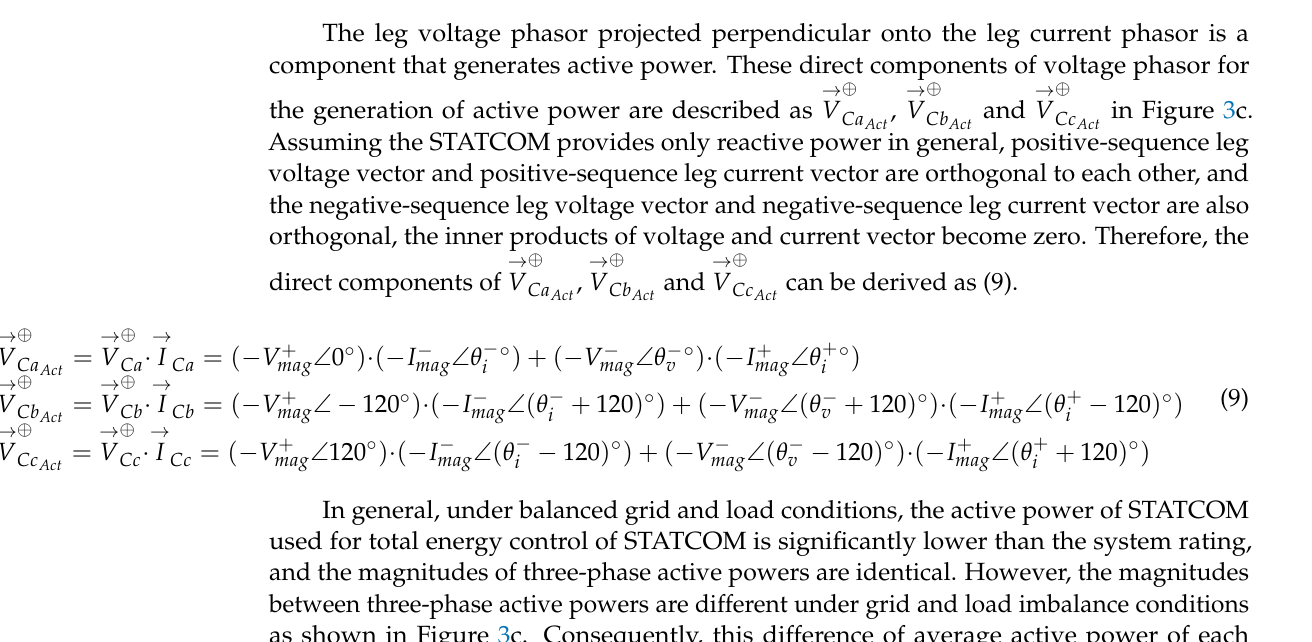
Figure 3. Phasor diagrams: ( a ) positive- and negative-sequence components of three-phase leg voltages and three-phase leg voltages without zero-sequence voltage; ( b ) three-phase leg currents and positive- and negative-sequence components of three-phase leg currents; ( c ) direct components of the active power, ( d ) circumcenter of the triangle made by three direct components of the voltage phasors; ( e ) feedforward component and leg voltages injected with zero-sequence voltage to compensate for power imbalance of each phase.